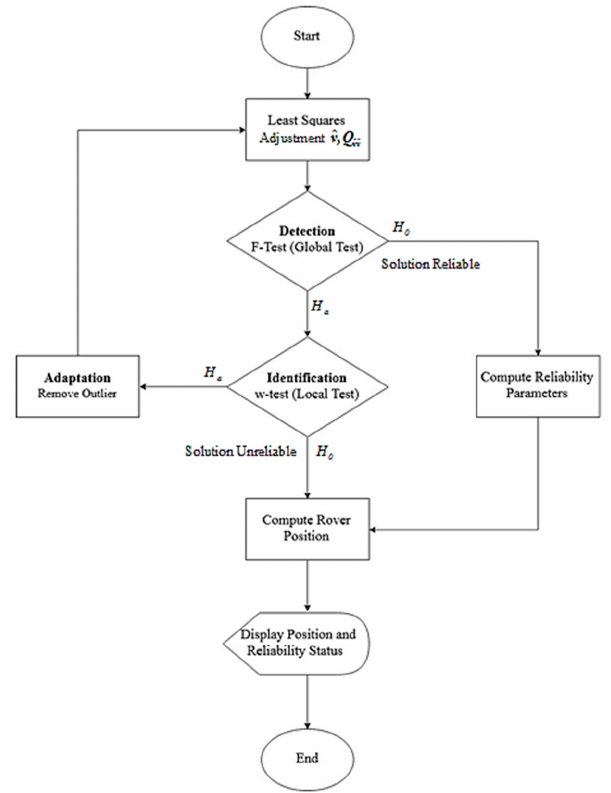
Figure 3. Flowchart for cycle slip (CS) detection and reliable positioning using the detection, identification, and adaptation (DIA) approach. identification, and adaptation (DIA)